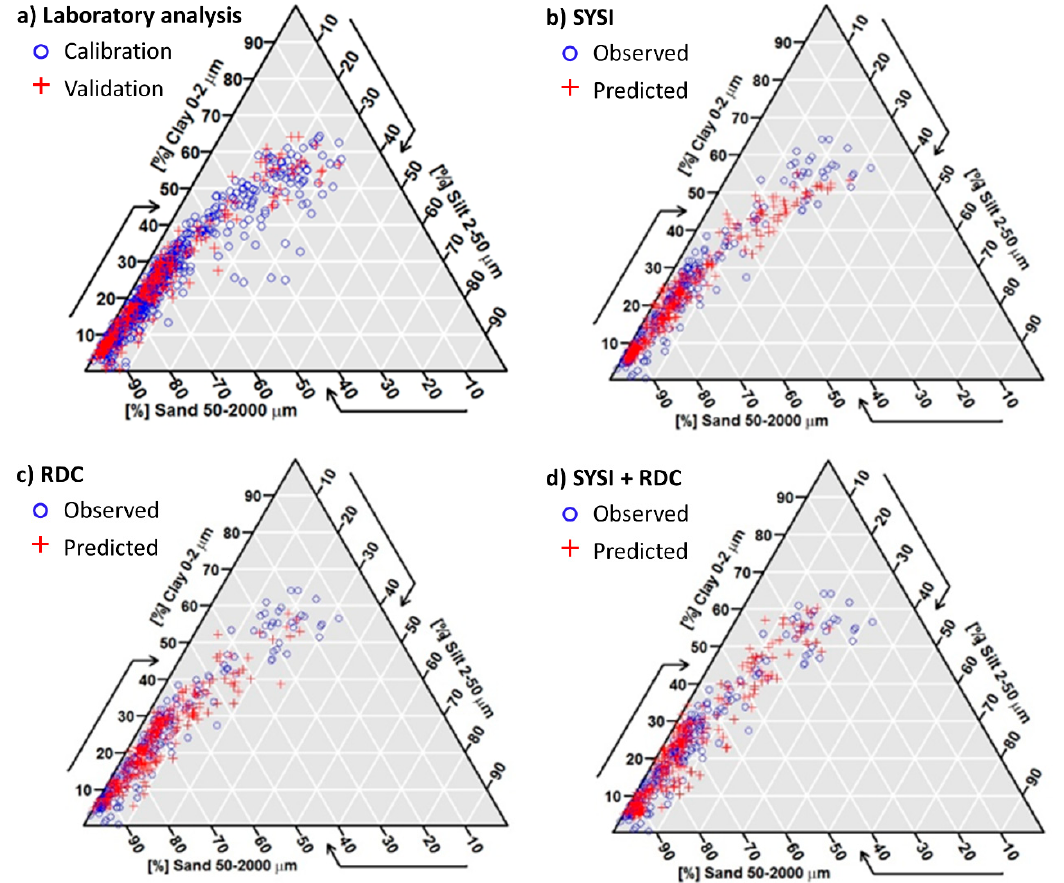
Figure 6. Soil texture triangle of calibration and validation datasets ( a ), comparing the observed and predicted clay and sand contents from the three mapping approaches: only the Synthetic Soil Image (SYSI) ( b ), only the Relief-Derived Covariates (RDC) ( c ), and SYSI plus RDC ( d ). The silt percent was estimated by the difference of 100% − (sand% + clay%).